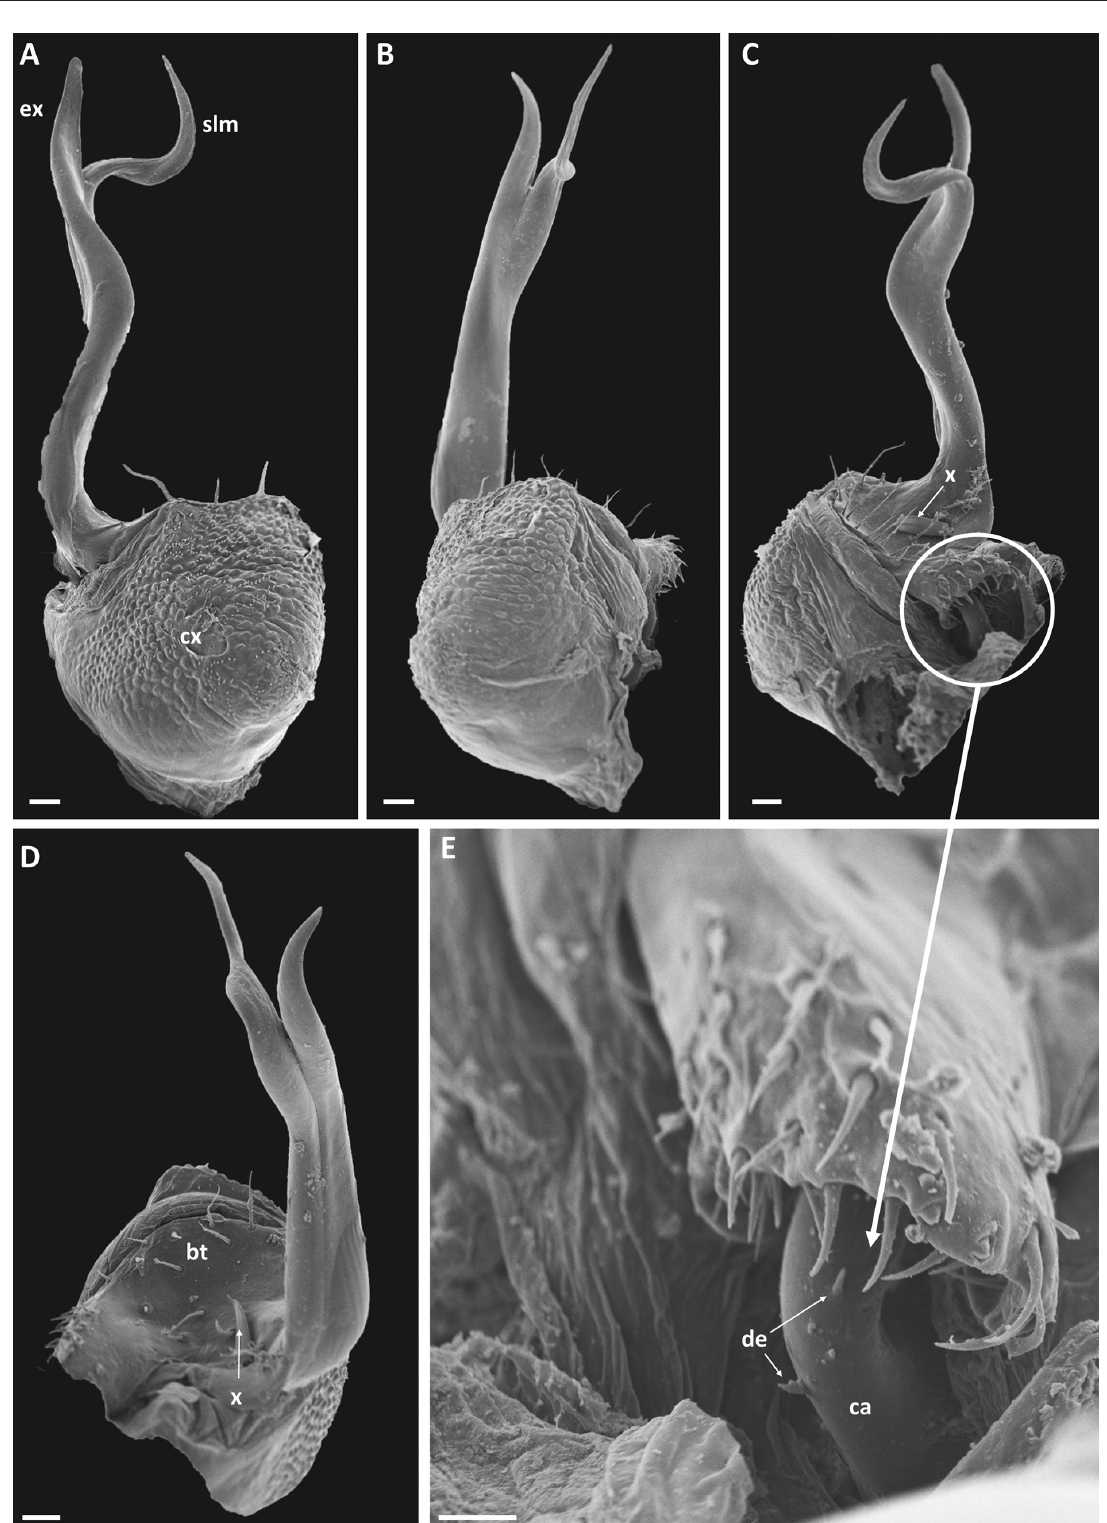
Fig. 11. Cryptocorypha exovo sp. nov., holotype (NHMD 621840), ♂, right gonopod. A . Lateral view. B . Posterior view. C . Mesal view. D . Anterior view. E . Close-up of circled area in D, showing cannula. Abbreviations: bt = basal part of telopodite; ca = cannula; cx = coxa; de = denticles; ex = exomere; slm = solenomere; x = ‘dirt’, not part of the gonopod. Scale bars: A–D = 0.02 mm; E = 0.01